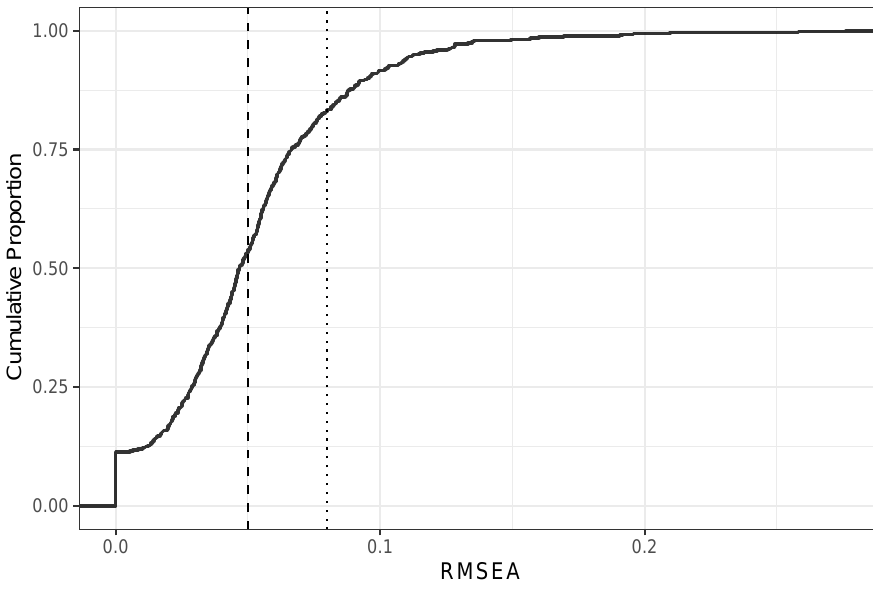
Figure 4: Distribution of fit values for simple confirmatory factor